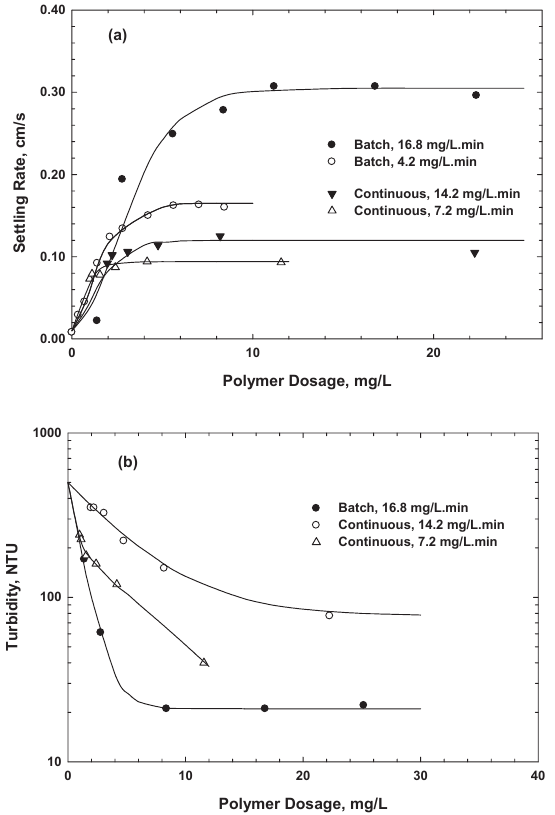
Fig. 10 Comparison of flocculation behavior in batch (with continuous polymer addition) and con- tinuous systems: (a) settling rate, (b) superna- tant turbidity. Data of Suharyono 22)